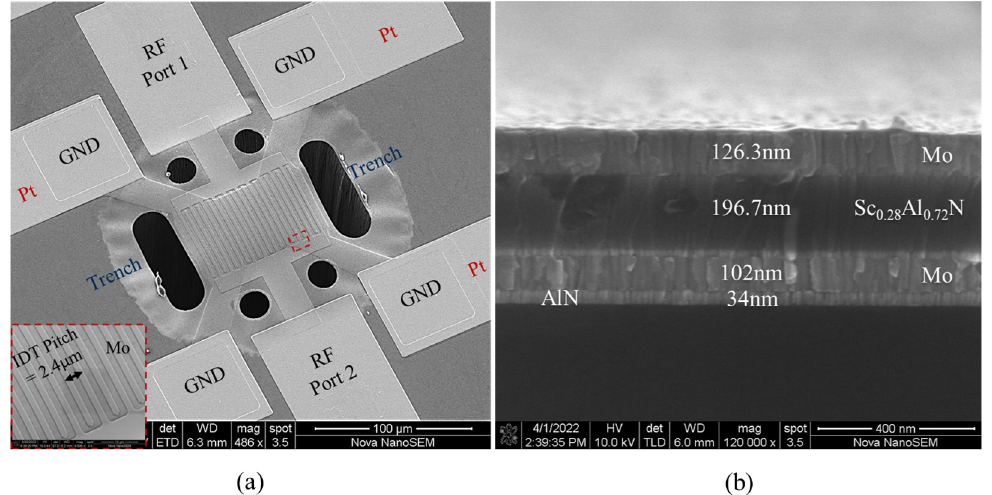
Figure 4. ( a ) SEM image of Sc 0.28 Al 0.72 N Lamb − wave resonator. The inset shows the IDT with a 2.4 µm pitch size. ( b ) Cross − sectional SEM image of the resonator, detailing constituent-layer thicknesses.